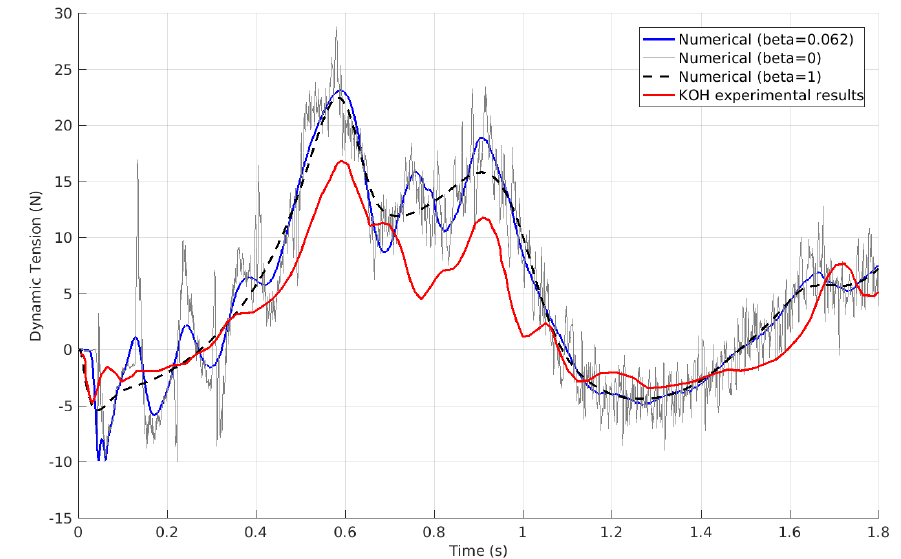
Figure 12. Numerical results for different β values compared with experimental